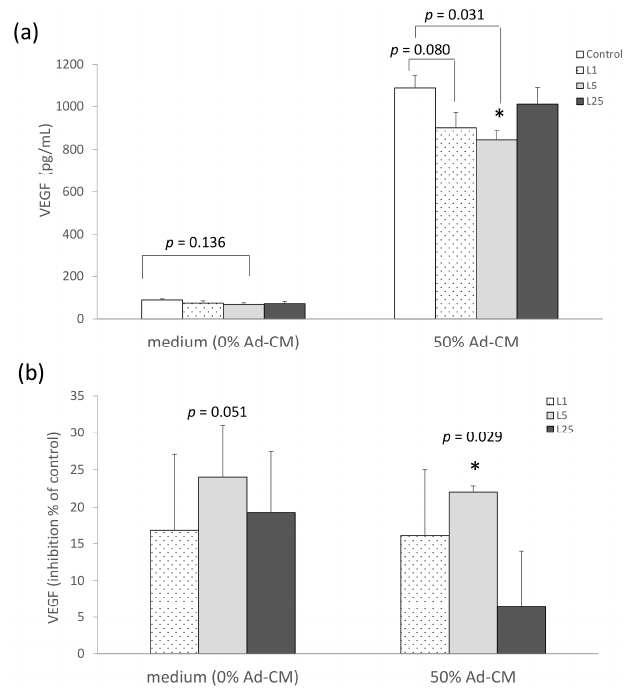
Figure 3. Effect of lunasin treatment on cytokine vascular endothelial growth factor (VEGF) production in 4T1 breast cancer cells. ( a ) Effect of lunasin on the amount of VEGF in 4T1 cells in complete medium or 50% Ad-CM; ( b ) Effect of lunasin on the amount of VEGF in 4T1 cells cultured in complete medium or 50% Ad-CM is presented as a percentage of inhibition relative to control (control as 0%). The VEGF production in supernatant obtained from 48 h culture medium was measured by enzyme-linked immunosorbent assay (ELISA). Data are shown as mean ± SEM. Statistical analysis was tested by one-way ANOVA and then Fisher’s LSD test; significant differences are presented as * p < 0.05 versus control